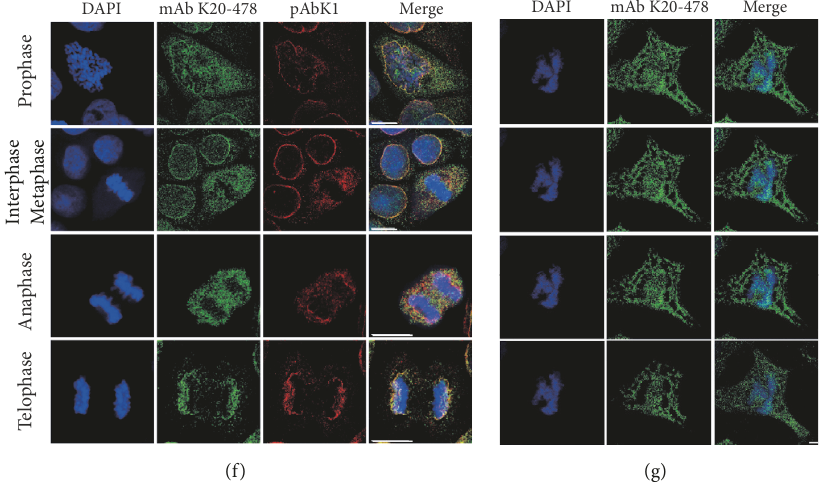
Figure 3: Interaction of Nesprin-2-SMC and Nesprin-2 with SMC2 and SMC4. (a) Precipitation of SMC2 and SMC4 with GST-Nesprin-2- SMC from HaCaT cell lysates. Precipitates were resolved on SDS-polyacrylamide gels (10% acrylamide) and probed with SMC2 and SMC4 specific antibodies. SPN, supernatant after pulldown; PD, pulldown. The lower molecular weight band in the SMC2 pulldown is presumably a breakdown product. (b) Immunoprecipitation of SMC2 from HaCaT cell lysates with Nesprin-2 specific mAbK20-478 and of Nesprin-2 with SMC2 specific antibodies. GFP-specific monoclonal antibodies were used for control. The antibodies used for immunoprecipitation are indicated above the panels (IP). The blots were probed with the antibodies listed on the right (WB). Immunoprecipitates were resolved on gradient gels (3–12% acrylamide) and 10% acrylamide gels as appropriate. The data are from one blot; however, the input was not directly adjacenttotheSMC2IP.(c)InteractionofCAP-H2(condensinII)andCAP-H(condensinI)withNesprin-2-SMC.Pulldownswereperformed with HaCaT cell lysates and GST for control and GST-Nesprin-2-SMC as indicated. Unsynchronized cells were used for the experiments shown in (a)–(c). (d) Analysis of the Nesprin-2-SMC interaction with SMC2 during the cell cycle. HaCaT cells were synchronized with RO- 3306 or other reagents as described in Materials and Methods in order to obtain the relevant cell cycle phases. Cell cycle phases were assessed by FACS analysis; the results are depicted in the accompanying diagram. Pulldown was carried out with GST-Nesprin-2-SMC bound to GST- Sepharose. GST was used for control. The blot was probed with SMC2 specific antibodies. (e) Localization of Nesprin-2 as detected with mAb K81-116-6 (green) during mitosis in HaCaT cells. DNA was stained with DAPI. Arrow points to filamentous staining across the chromosomes. (f) Nesprin-2 distribution in HaCaT cells during mitosis as detected with mAb K20-478 (green) and pAbK1 (red). DNA was detected with DAPI. Bar, 10 𝜇 m. (g) Nesprin-2 presence on chromosomes. Different Z-stacks (from top to bottom: 0 𝜇 m, 0.21 𝜇 m 0.42 𝜇 m, and 0.84 𝜇 m) from a COS7 cell in anaphase stained with mAb K20-478. DNA was stained with DAPI. Bar, 5 𝜇 m.